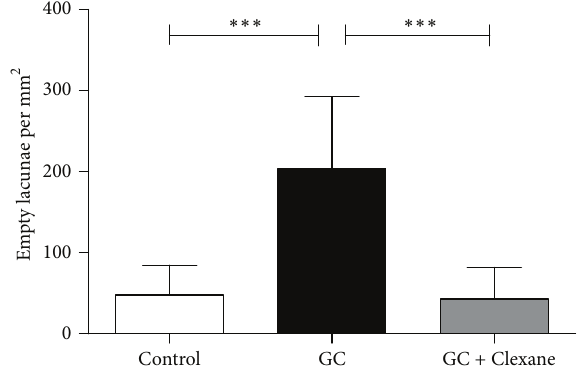
Figure 2: Enoxaparin treatment decreases glucocorticoid-induced osteonecrosis. The application of enoxaparin with methylprednisol- one reduces significantly the amount of empty osteocyte lacunae per mm 2 in the femoral head of rabbits due to methylprednisolone treatment to control levels. The graph represents the mean score with SEM of empty lacunae. Statistical analysis was performed with one-way ANOVA followed by Bonferroni’s multiple comparison test (control versus GC, control versus GC + Clexane, and GC versus GC + Clexane). ( ∗∗∗ 𝑃 < 0.0001